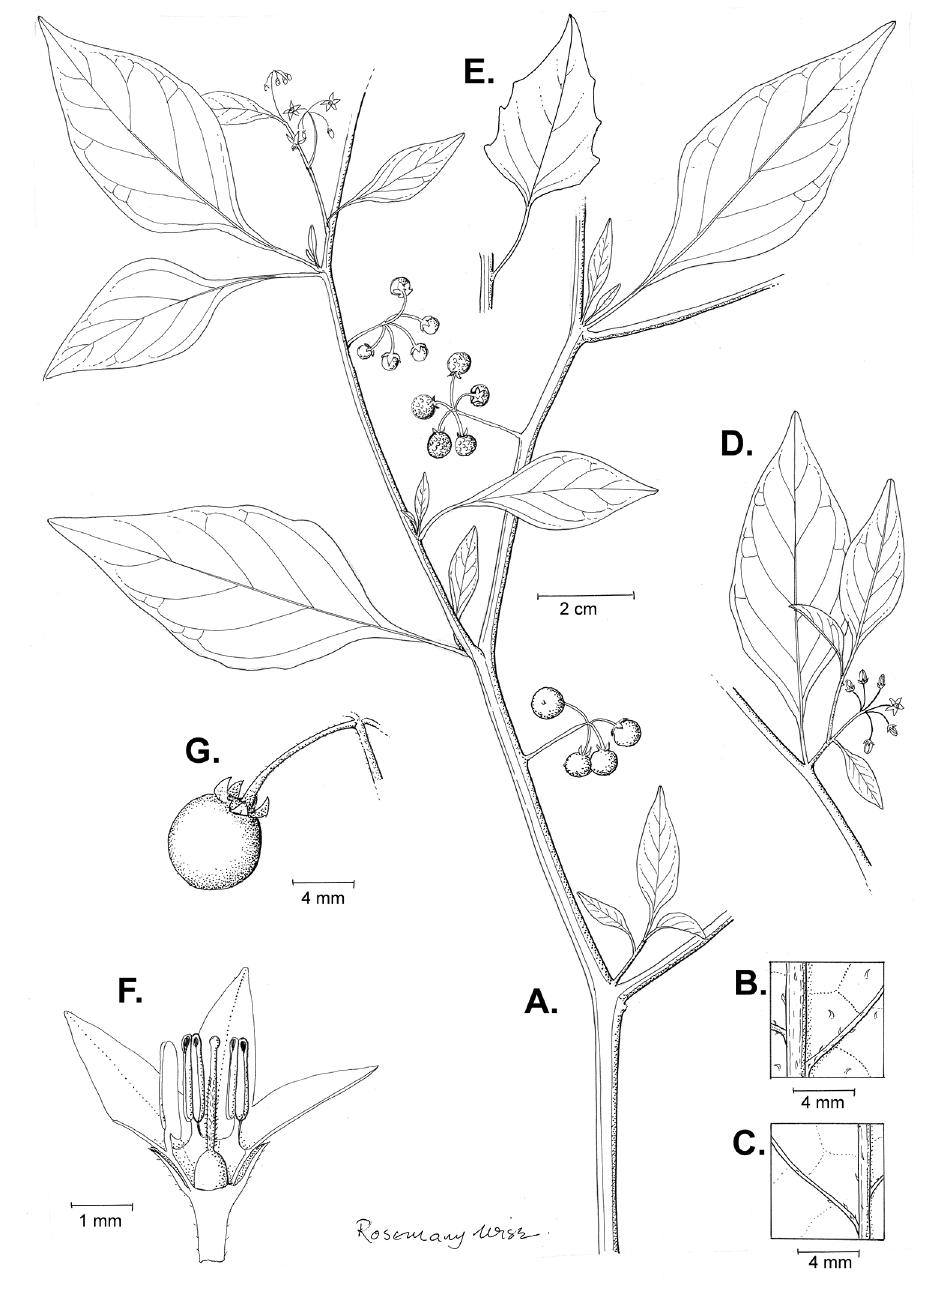
Figure 3. Solanum americanum Mill. A Habit B detail of abaxial leaf surface C detail of adaxial leaf sur- face D branch with inflorescence E leaf F dissected flower G fruit ( A–D, F–G Cremers 8084 E Farrugia 2773 ). Drawing by R. Wise (previously published in “PhytoKeys